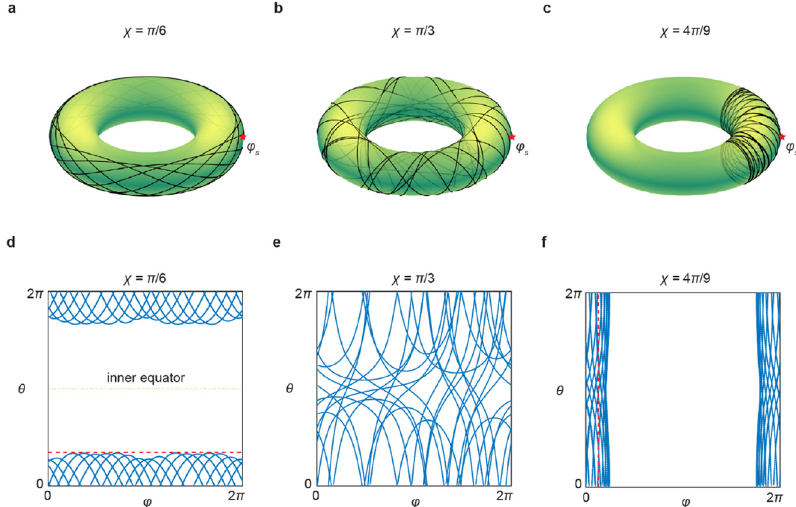
trajectories for small values of angle χ are shown in Figure 3a and d. The rays are con fi ned along the θ direction within the region near the outer equator, which are the re fl ected-type rays and correspond to the curly lines in phase space at the upper part of Figure 1e. In Figure 3b and e, we consider a value of χ located in the chaotic region, and the con fi nement ceases to be effective and rays goes through the manifold freely. As the angle further increases and go beyond the chaotic region, the rays are again con fi ned as shown in Figure 3c and f. However, the con fi nement is now along the φ direction, which is caused by the curvature difference at different φ positions. The manifestation of this ray trajectory in phase space is a half- closed circle in lower part of Figure 1e. It is worth to note that for the special condition of ray trajectories being closed, the Birkhoff coordinates will show up as islands in phase diagram, as can be found from Figure 1d – f.